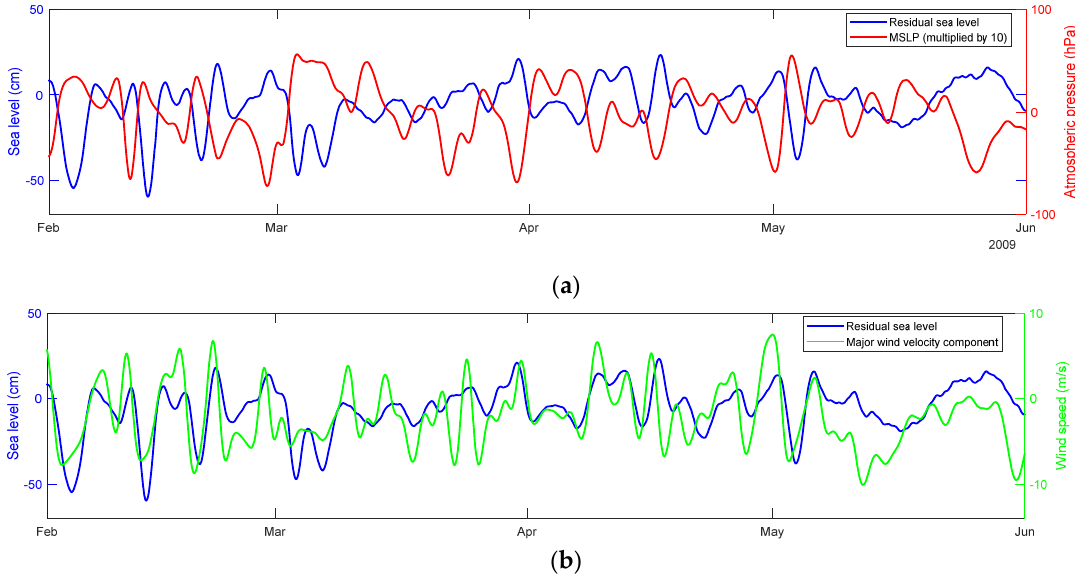
Figure 11. Low ‐ pass ‐ filtered time series of sea level compared with ( a ) MSLP, and ( b ) major wind velocity component at Bushehr station.